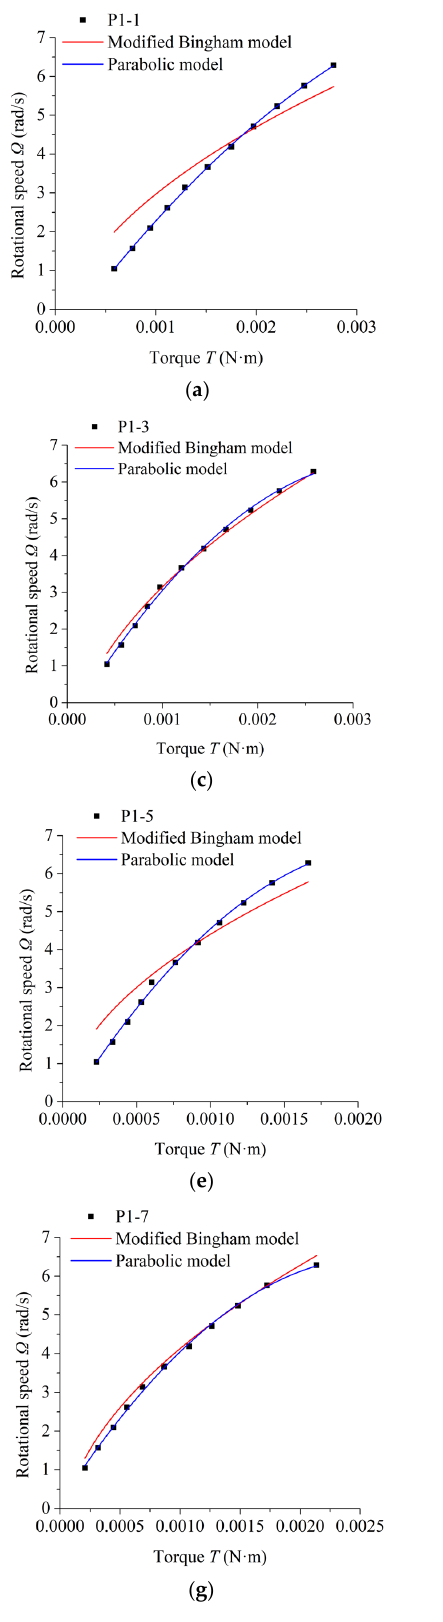
Figure 4. Comparison of fitting results of P1 between modified Bingham model and